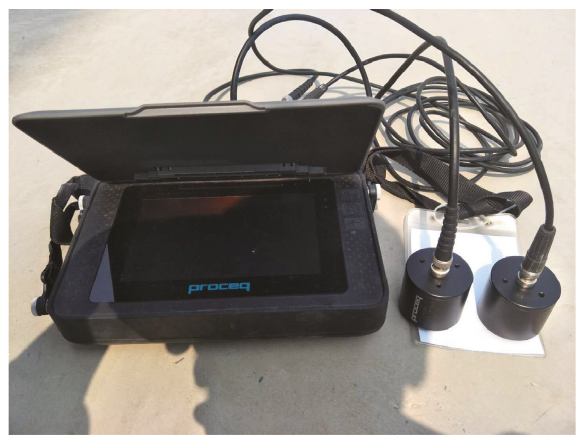
Figure 7: Pundit PL-200